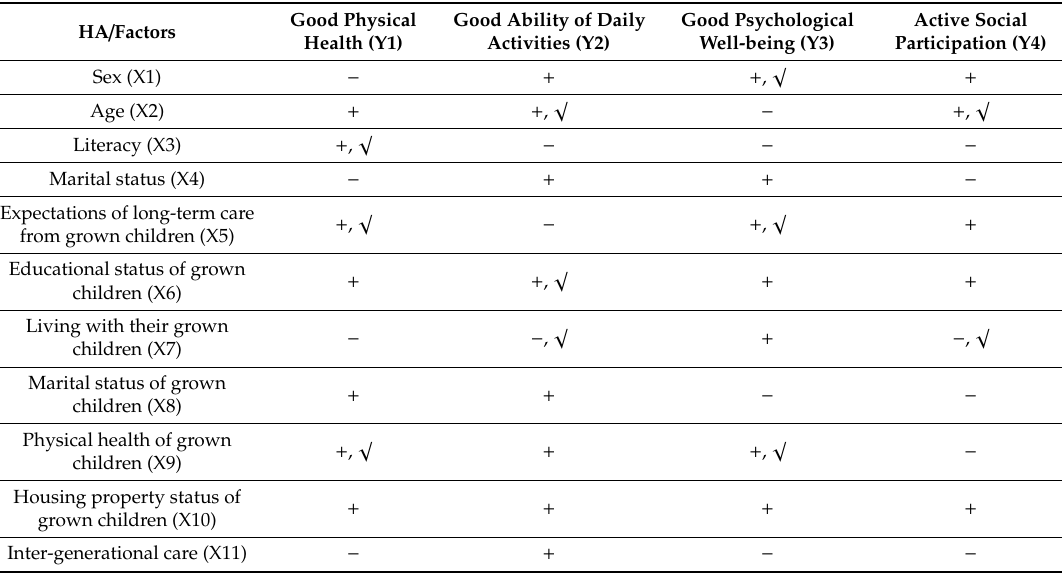
Table A2. Statistical comparison of